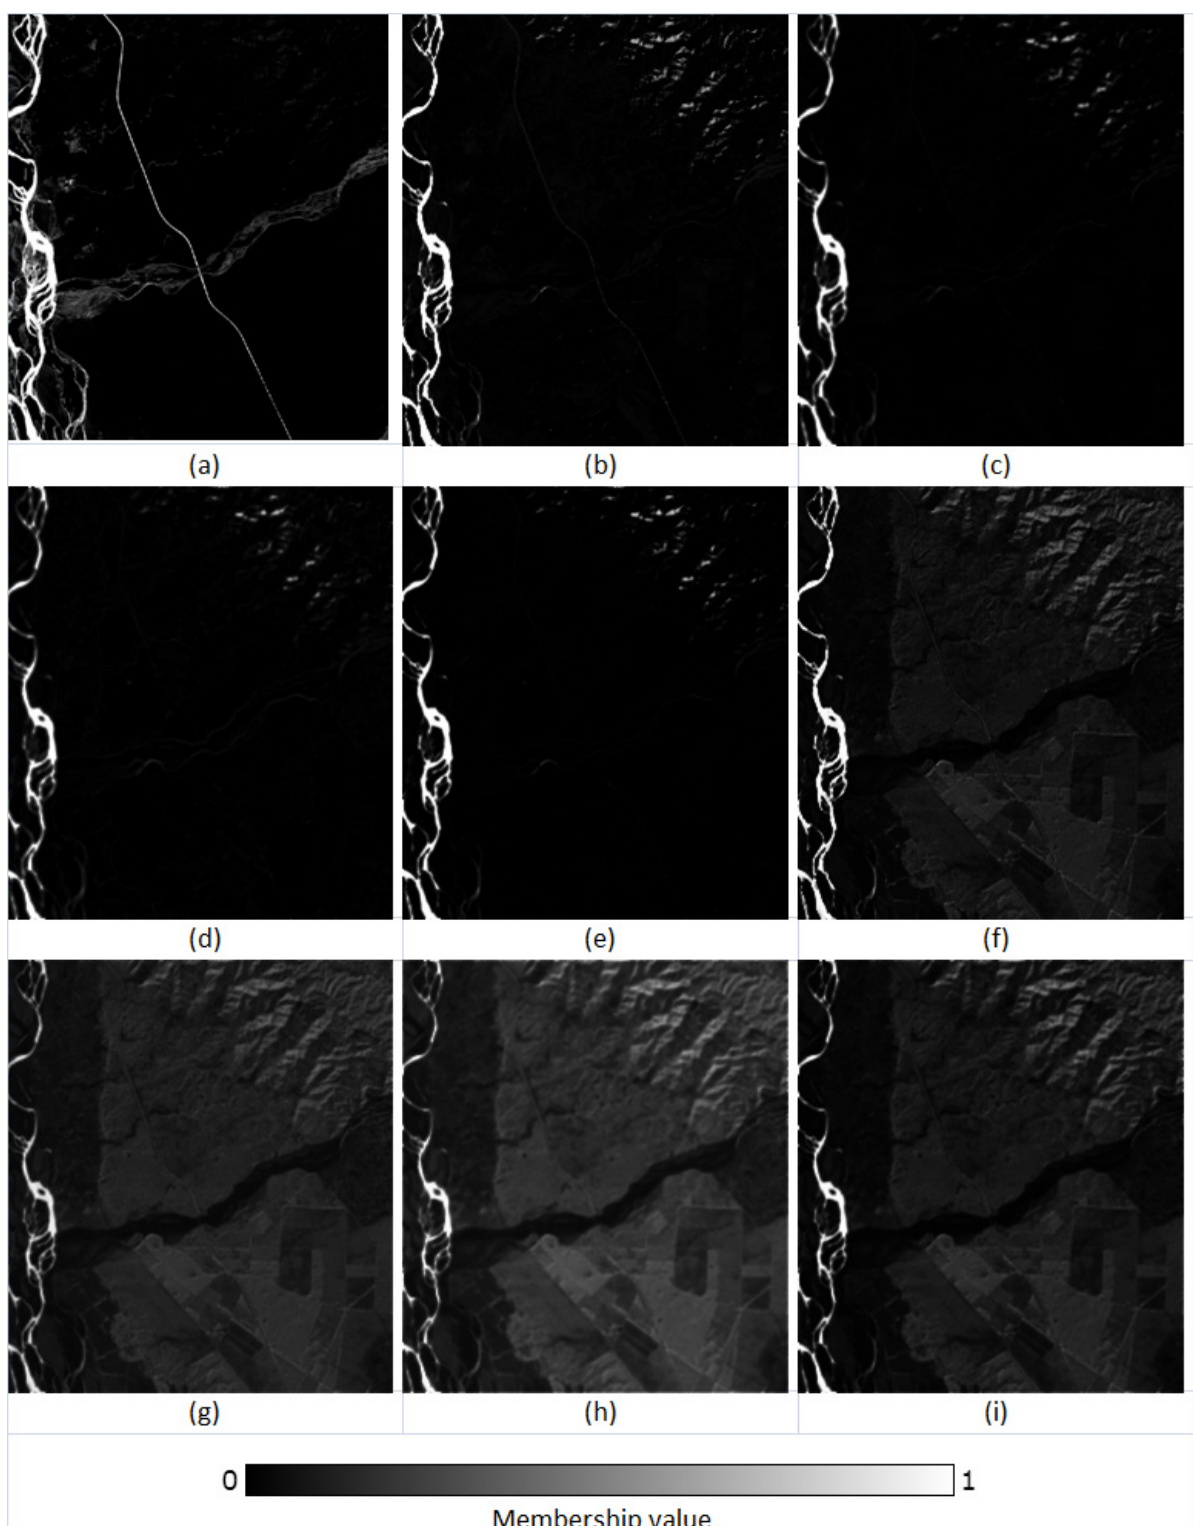
Figure 8. The membership fraction (0–1) for the class ‘Water’ in ( a ) reference, ( b ) FCM output, ( c ) FCM-S output, ( d ) FLICM output, ( e ) ADFLICM output, ( f ) PCM output, ( g ) PCM-S output, ( h ) PLICM output, and ( i ) ADPLICM output.